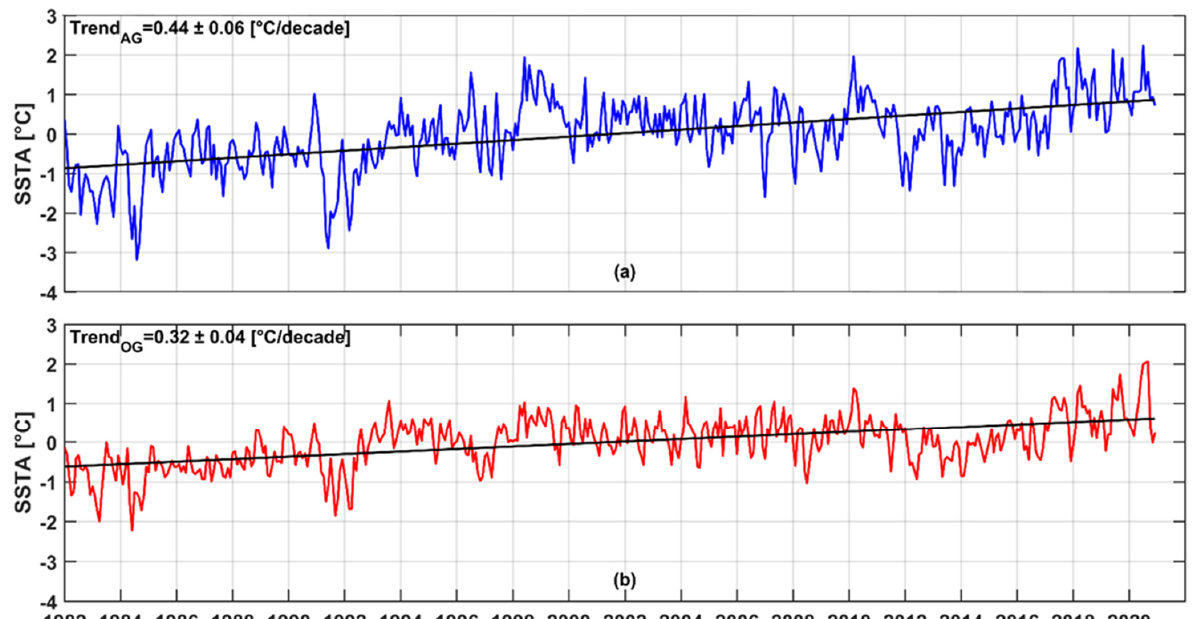
Figure 3. The temporal evolution of the monthly averaged SSTA for AG ( a ) and OG ( b ) from 1982 to 2020. The SSTA trend is shown by the solid black line.